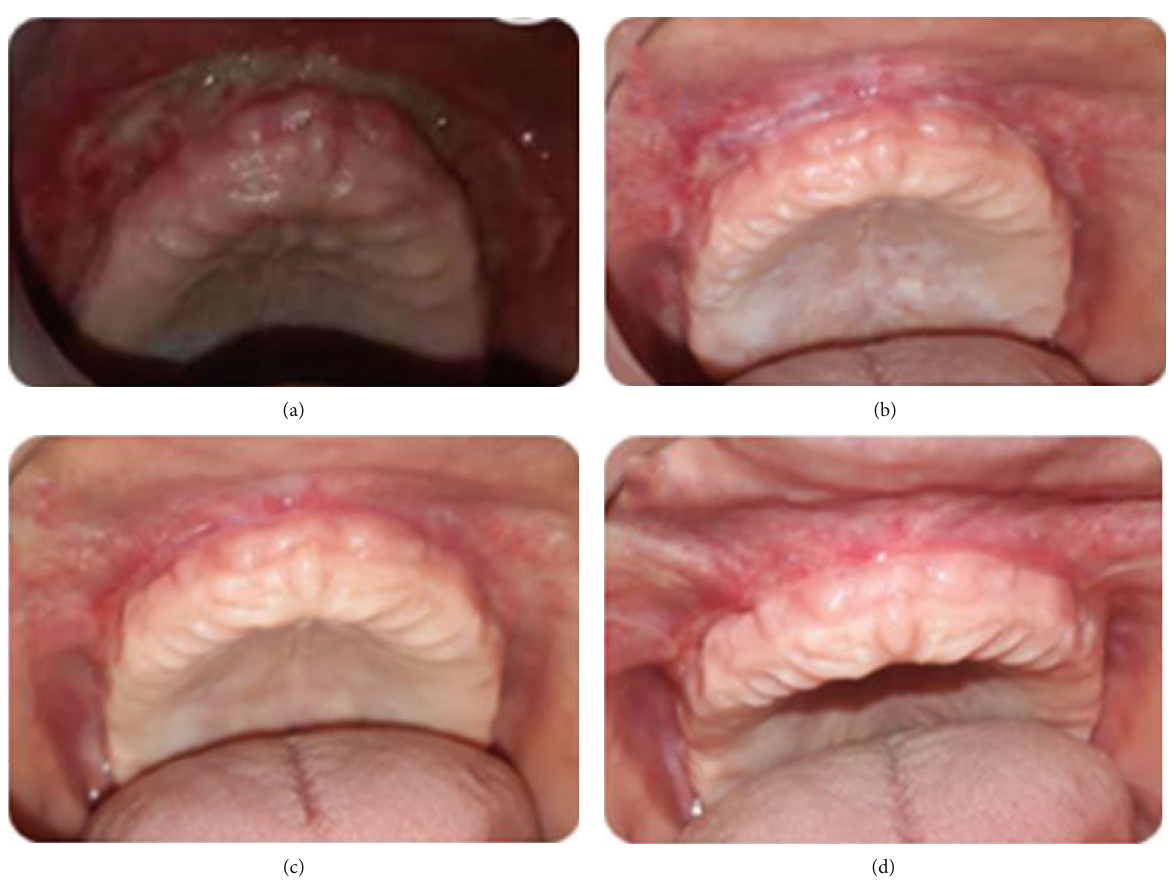
Figure 28: Healing process: (a) 3 days, (b) 1 week, (c) 2 weeks, and (d) 1